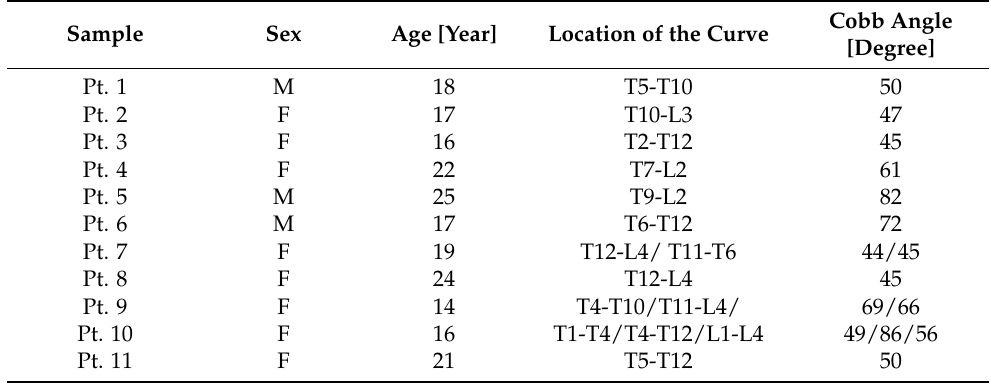
Table 1. Basal characteristic of AIS